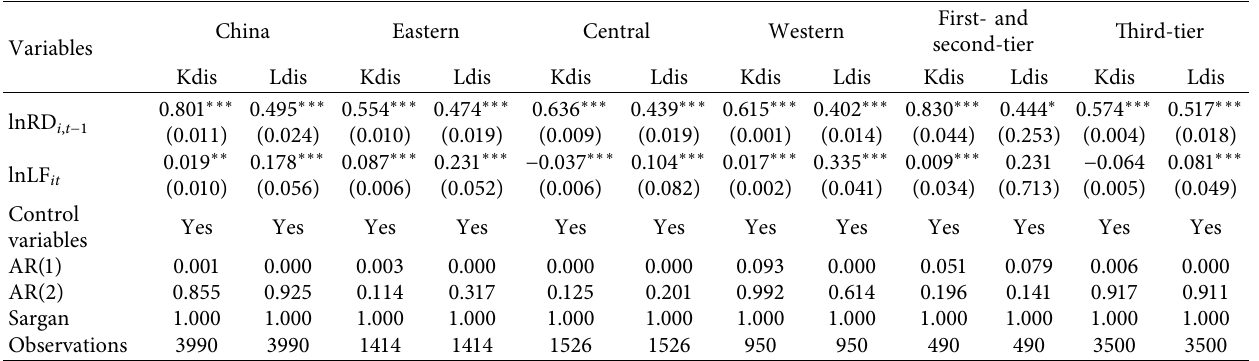
Table 5: Results of robustness tests based on the SYS-GMM